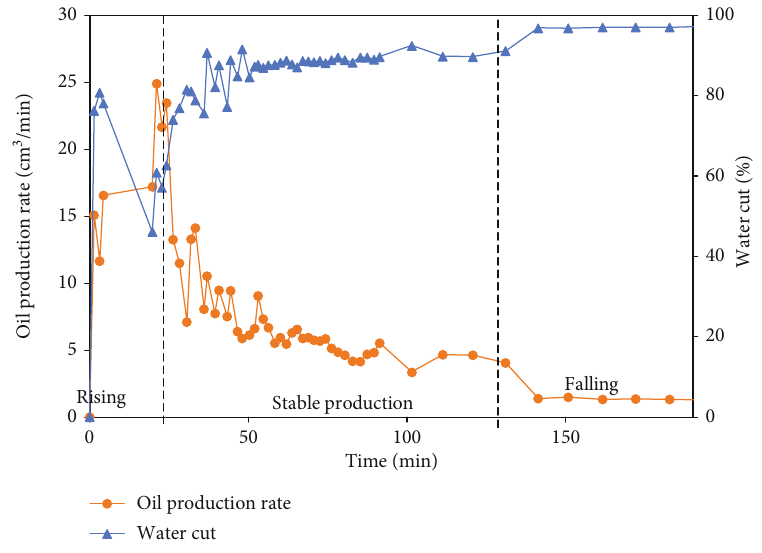
Figure 17: The oil production rate and water cut of 300 ° C superheated SAGD.